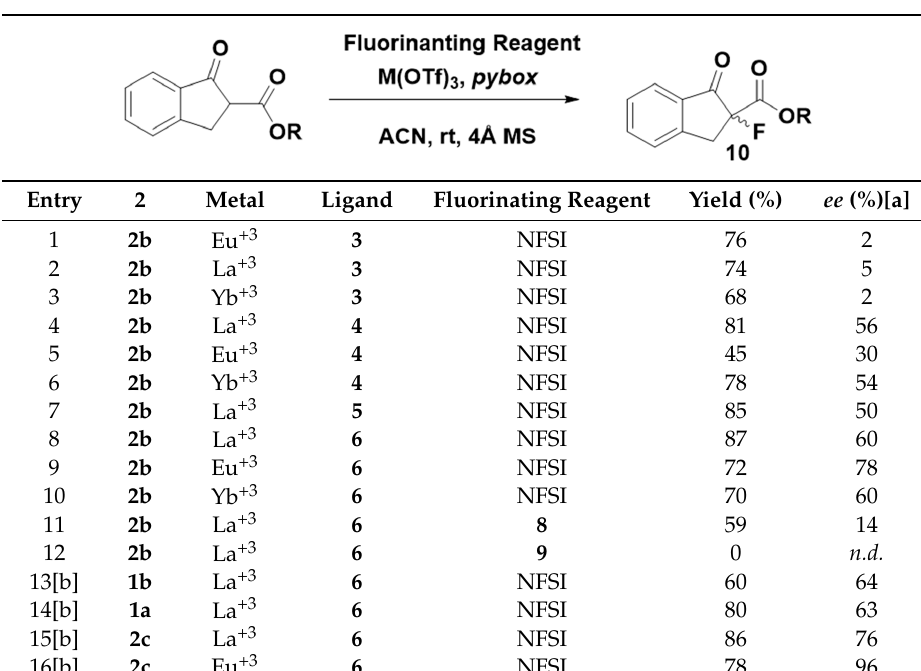
Table 1. Optimization of the enantioselective α -fluorination reaction.